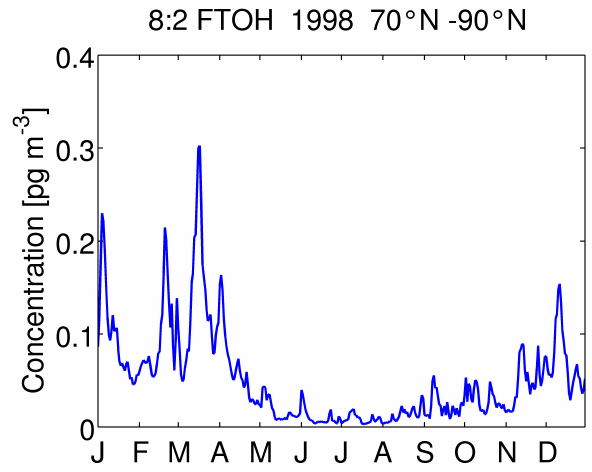
Fig. 3. One-year time series of daily mean concentration of 8:2 FTOH in the near-ground Arctic atmosphere (1998, spatially averaged over > 70 ◦ N).